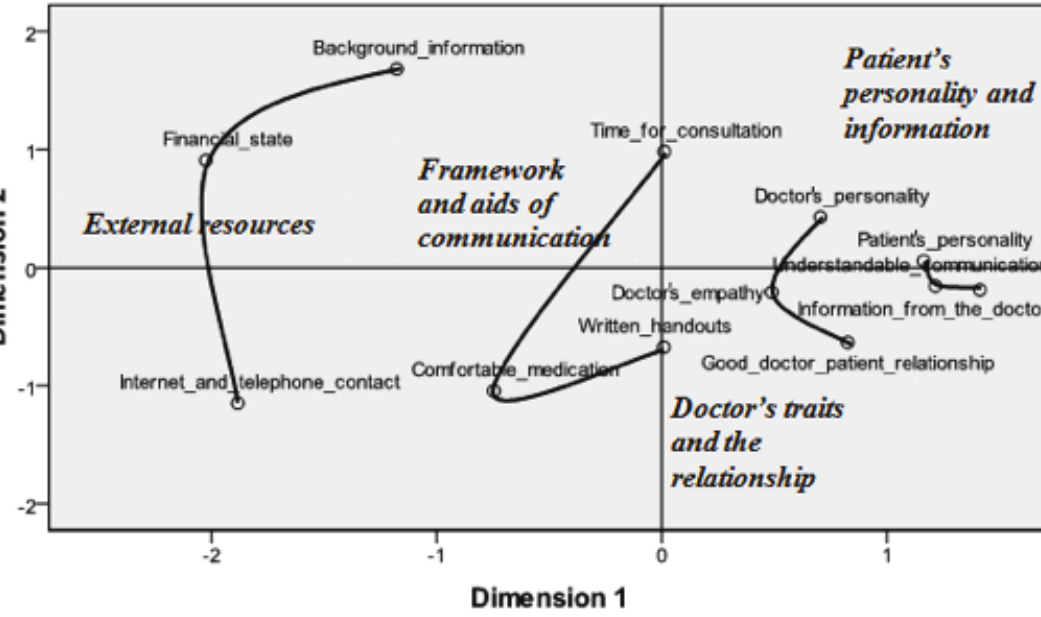
Figure 2: Results of the multidimensional scaling of chronic skin patients’ answers to the questionnaire, with the four major content groups indicated